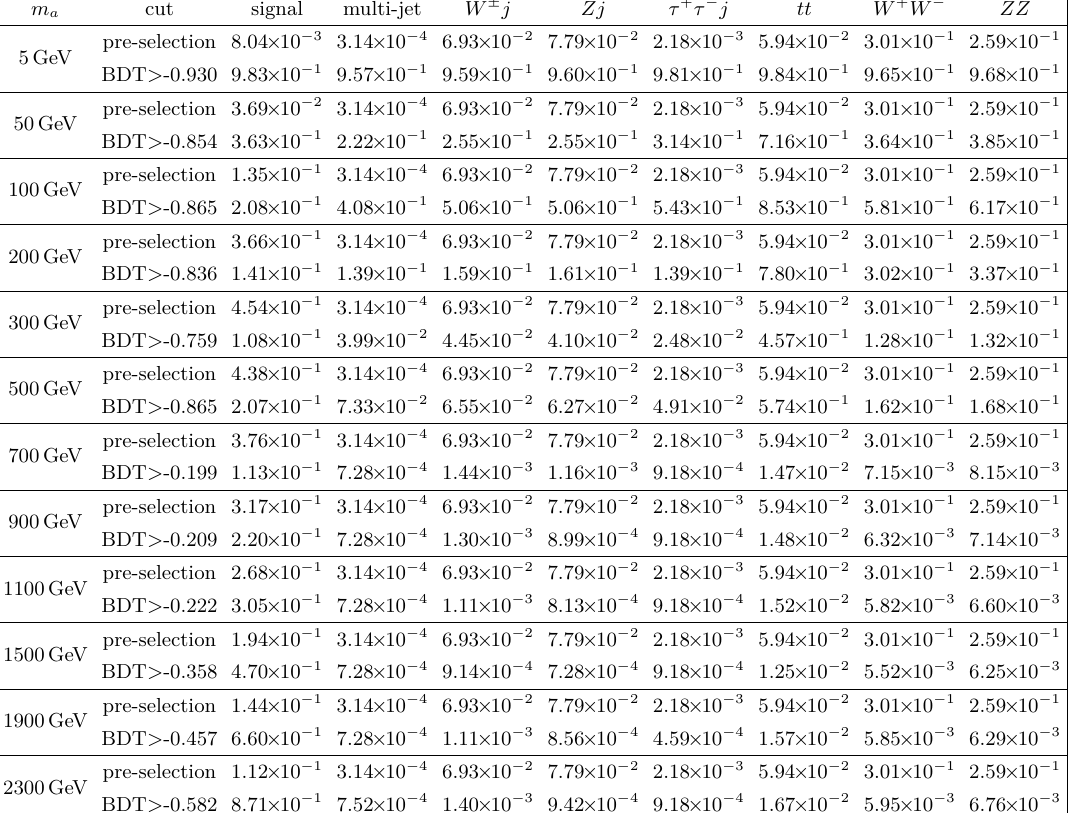
Table 3 . Selection efficiencies for the signal processes with a range of representative ALP masses and fixed C ˜ /f a = 10 − 2 TeV − 1 and the background processes multi-jet, W ± j , Zj , τ + τ − j , t ¯ t , G W + W − and ZZ at the HL-LHC with center-of-mass energy Open